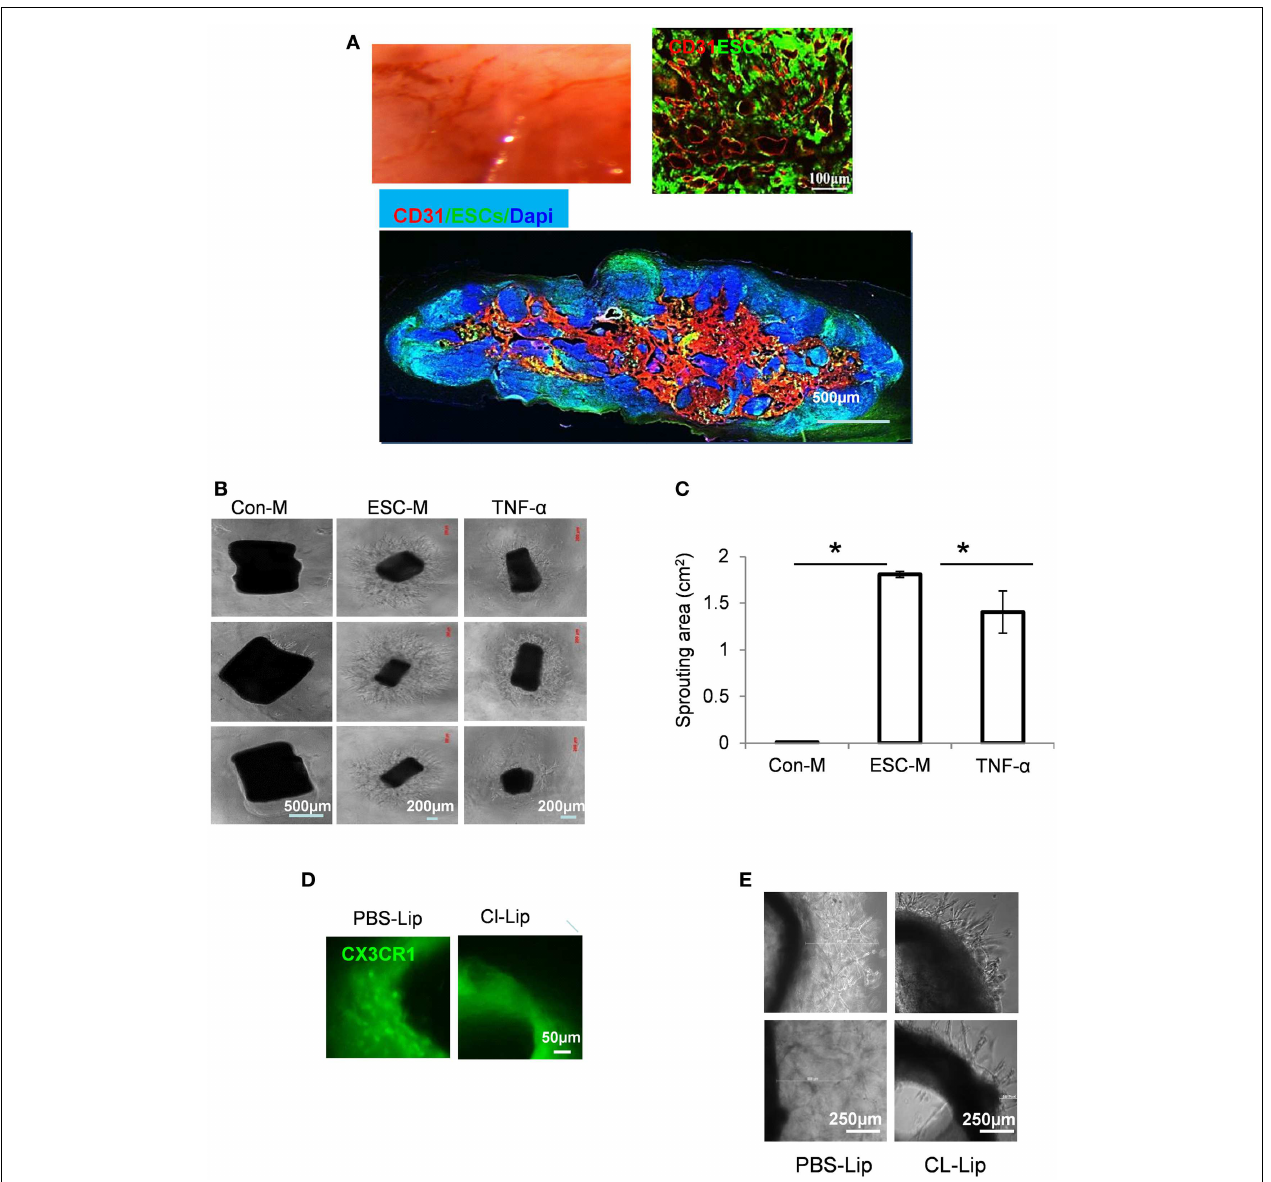
sprouting at day 6 in Con-M, ESC-M, andTNF- α was measured by ImageJ ( n = 6, * p < 0.05, two-sidedWilcoxon test. Data are represented as mean ± SEM). (D) Representative gross morphology of aortic ring from CX3CR1 GFP/ + mice treated with PBS-Lip (left) and CL-Lip for 4weeks (right). (E) Mice were treated with PBS-Lip (left) and CL-Lip (right) for 4weeks and aortic rings were cultured in Matrigel containing ESC-M for 6days. Representative gross morphology of aortic ring sprouting was